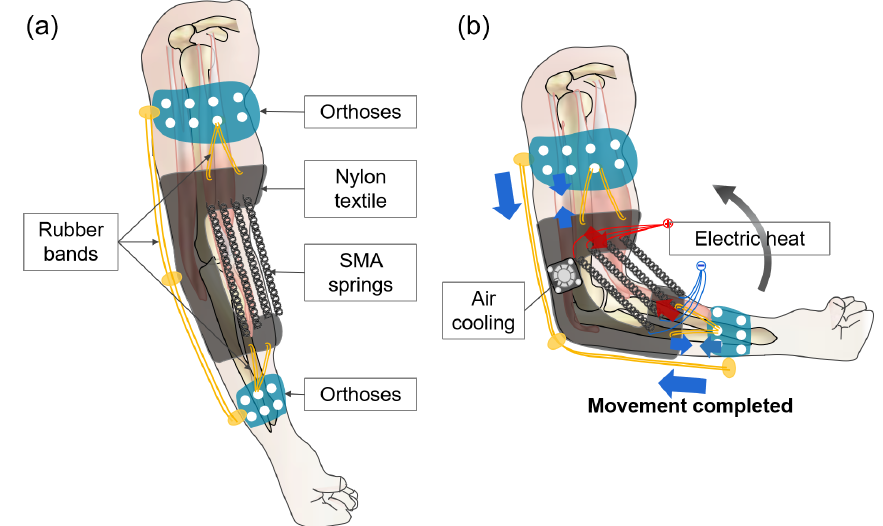
Figure 1. Schematic diagram of a novel soft bionic elbow exoskeleton based on SMA spring actuators (Sobee-SMA). (a) Schematic diagram of Sobee-SMA. (b) Force analysis of elbow exoskeleton flexion.